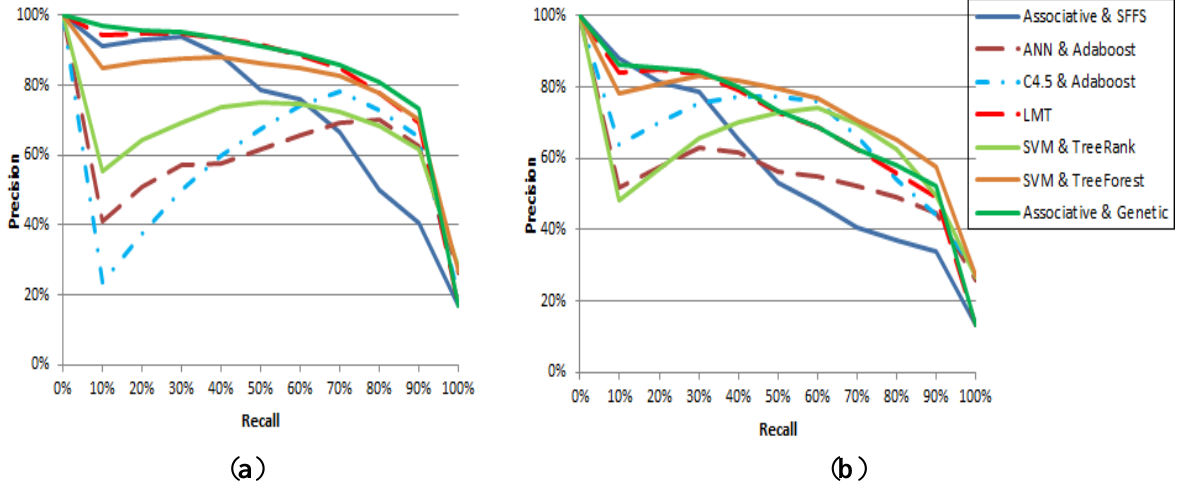
Figure 11. Average precision-recall results for comparative experiments for ranking images by semantics using seven different ranking methods on ( a ) the UCI Statlog Landsat data set and ( b ) WROC data